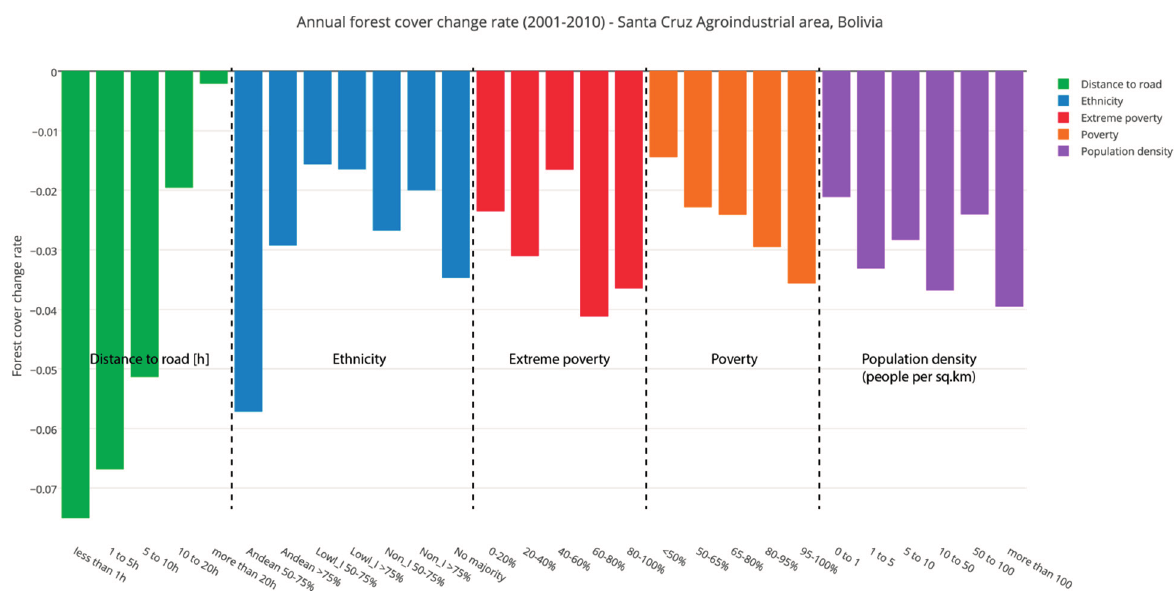
Figure 6. Forest cover change rate in relation with socio-economic variables in the Santa Cruz agroindustrial area